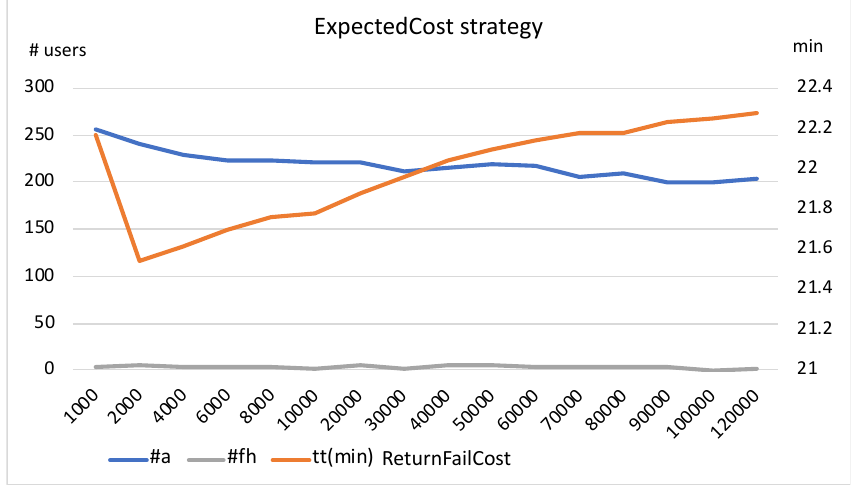
Figure 2. ExpectedCost strategy with fixed RentFailCost = 50,000 and varying ReturnFailCost .